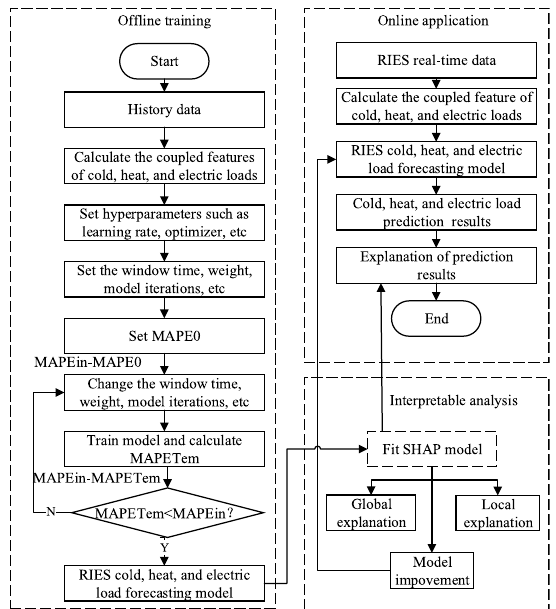
Fig. 4 RIES load prediction and interpretable analysis